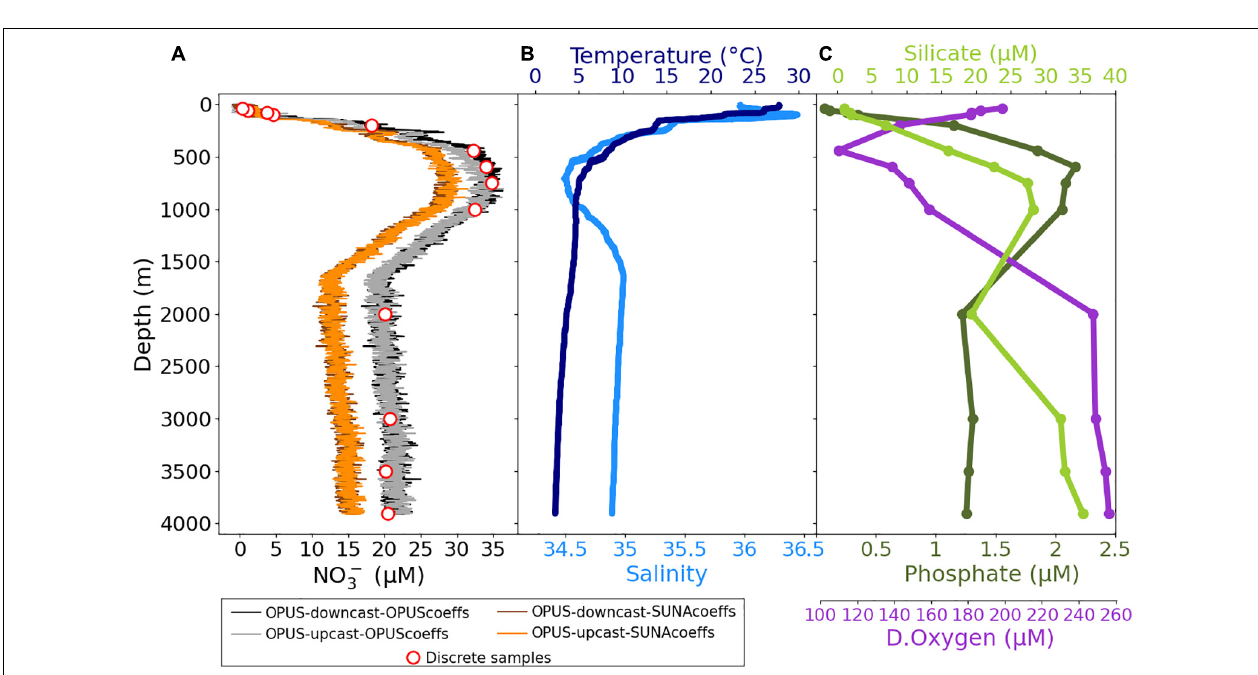
FIGURE 13 | Distributions of surface NO 3 − concentrations ( µ M) obtained using the OPUS sensor (left panel) and surface salinity values recorded by the CTD (right panel) during the Sternfahrt-1 expedition. Color bars represent the levels of NO 3 − (left) and salinity (right) data.